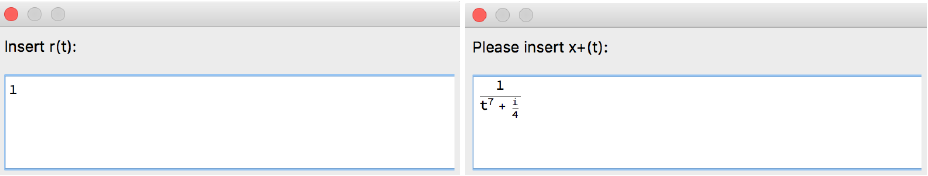
Figure 63. Output given by the [SInt] 2.0 algorithm.